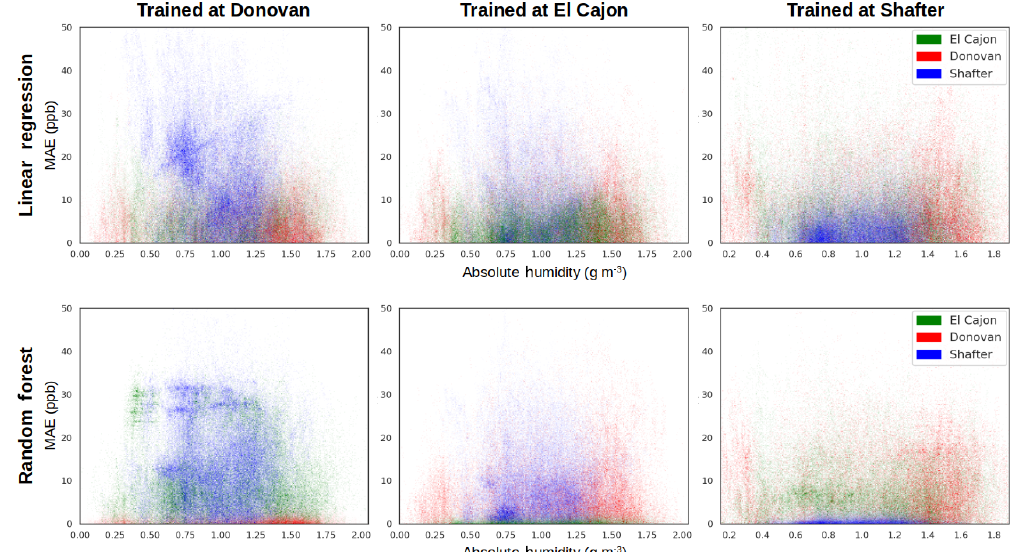
Figure 8. Error density plots for O 3 versus normalized absolute humidity for both linear regression (LR) and random forest (RF) in a Level 1